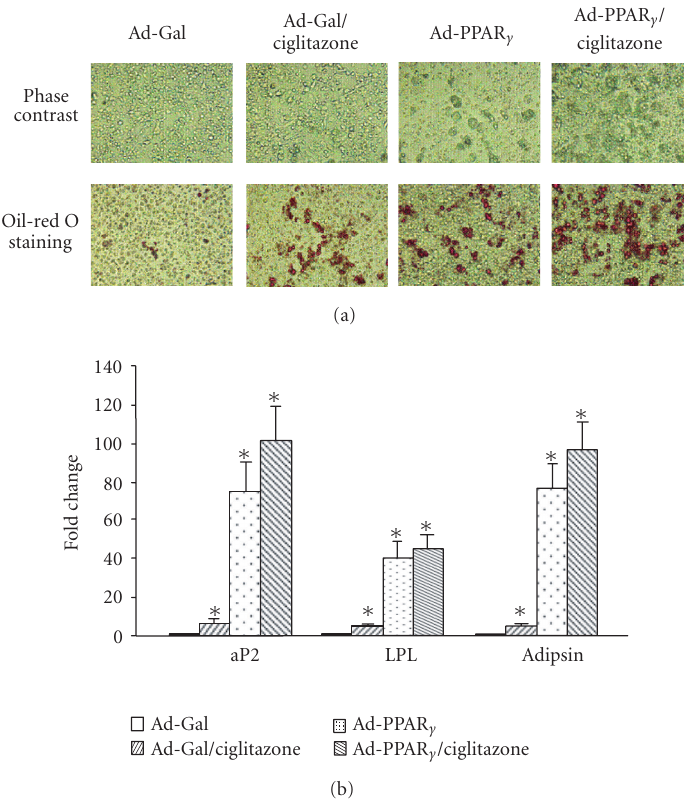
Figure 2: Adipogenic changes in the growth plate cells in which PPAR γ was overexpressed or cells treated with ciglitazone. (a) Growth plate cells were infected with Ad-PPAR γ or Ad-Gal followed by a 10-day incubation in the presence or absence of ciglitazone (5 μ M). Cells were observed under the phase contrast microscope with 10-fold magnification. Oil Red-O staining shows lipid accumulation within the cells. (b) Quantitative real-time PCR analysis of the adipogenic marker genes aP2, LPL, and adipsin, in growth plate cells at day 4 of the culture. Ad-Gal- infected cells were used as controls. Gene expression levels were normalized with respect to endogenous 18S rRNA. ∗ P < . 05 versus the expression in control